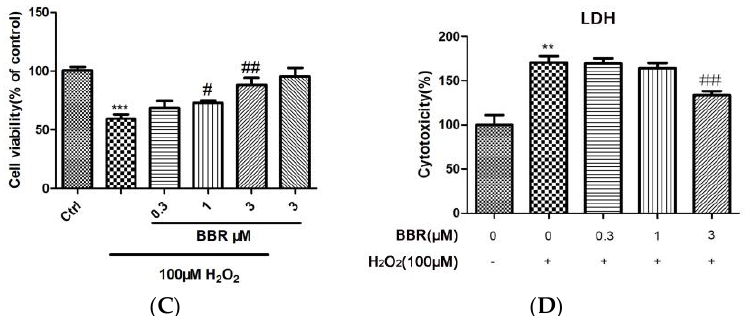
Figure 1. Protective effects of berberine (BBR) against H 2 O 2 -induced cytotoxicity in D407 cells. ( A ) The structure of BBR; ( B ) D407 cells were treated with BBR (0.3 to 30 µM) or 0.1% dimethyl sulfoxide (DMSO) (vehicle control) for 24 h and cell viability was measured using 3-(4,5-dimethylthiazol-2-yl)-2,5-diphenyl tetrazolium bromide (MTT) assay. Cells were pre-treated with BBR at indicated concentration or 0.1% DMSO (vehicle control) for 2 h and then incubated with or without 100 µM H 2 O 2 for further 24 h. Cell viability and the release of lactate dehydrogenase (LDH) were measured by MTT assay ( C ) and LDH assay ( D ), respectively. * indicates p < 0.05, ** indicates < 0.01, *** indicates p < 0.001 versus the control group; # indicates p < 0.05, ## indicates p < 0.01 versus the H 2 O 2 -treated group were considered significantly different.